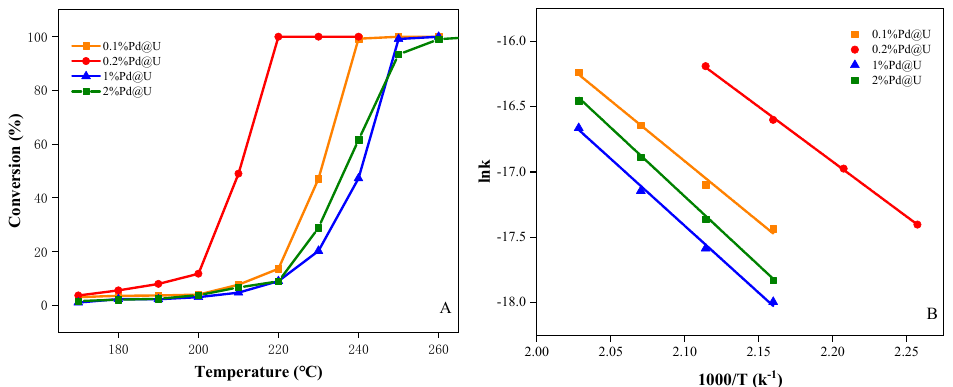
Figure 5. ( A ) Toluene conversion and ( B ) Arrhenius plots for toluene oxidation over the samples under the conditions of toluene concentration = 1000 ppm, 20 vol % O 2 , and WHSV = 60,000 mL (g · h) − 1 .